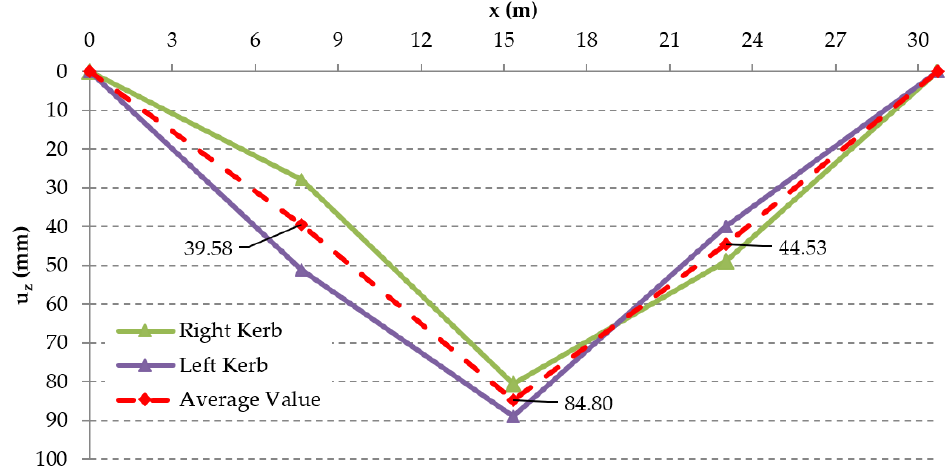
Figure 23. Measured deflections of the bridge using Geodetic Surveying.